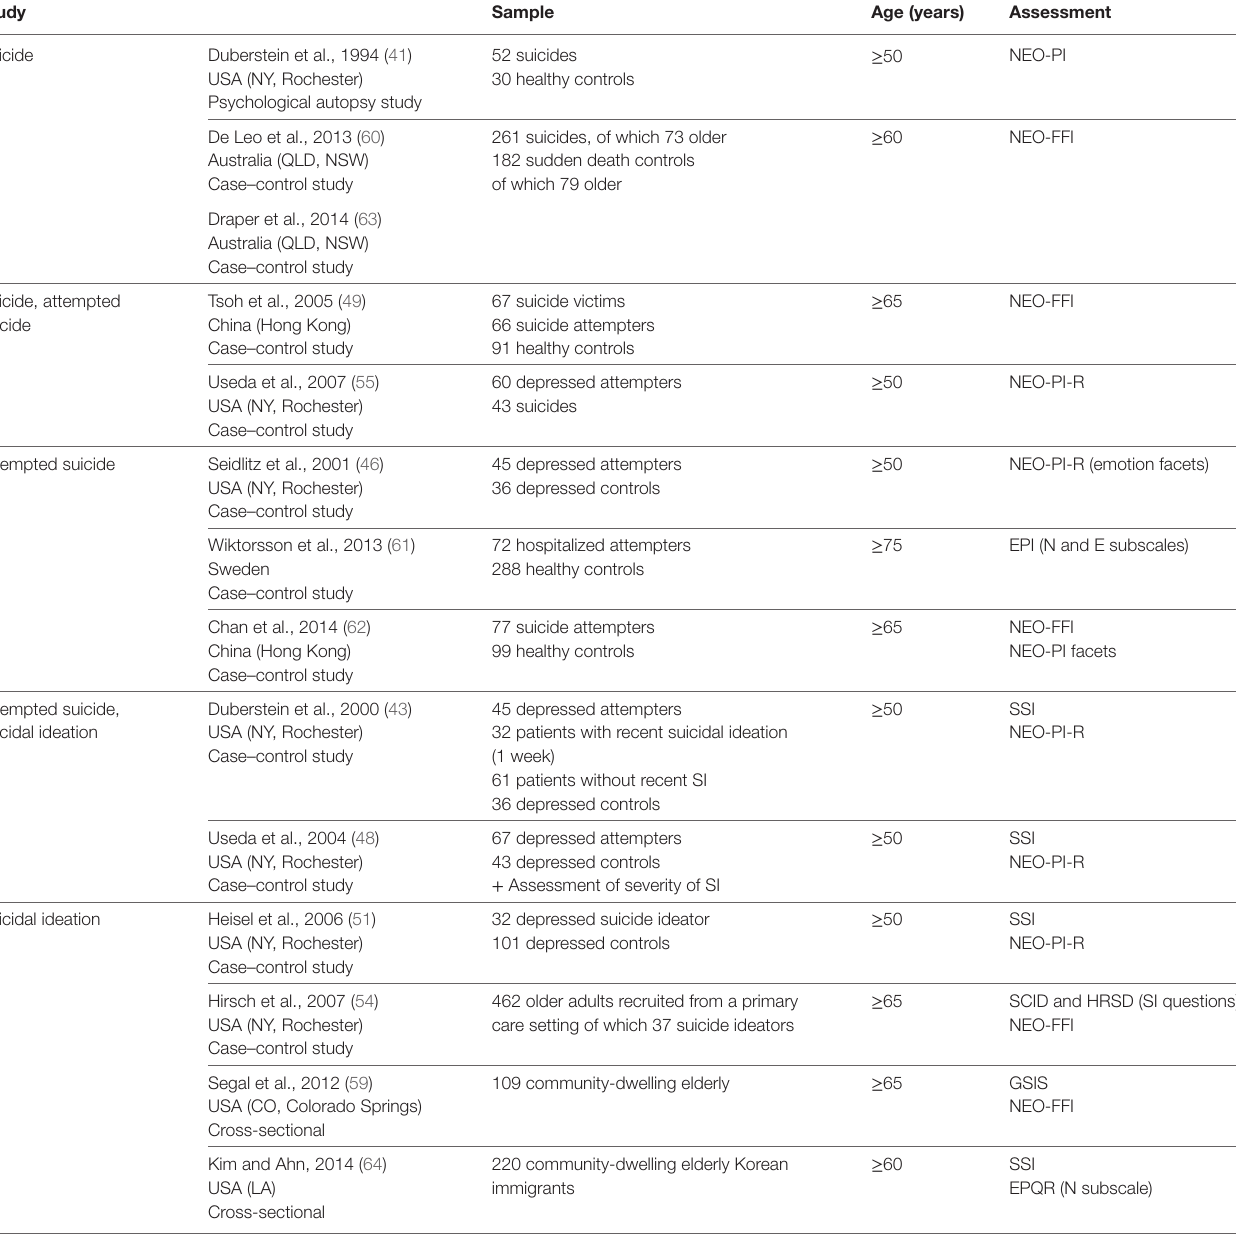
taBLe 4 | Characteristics of studies with dimensional findings (see table 5 for a summary of